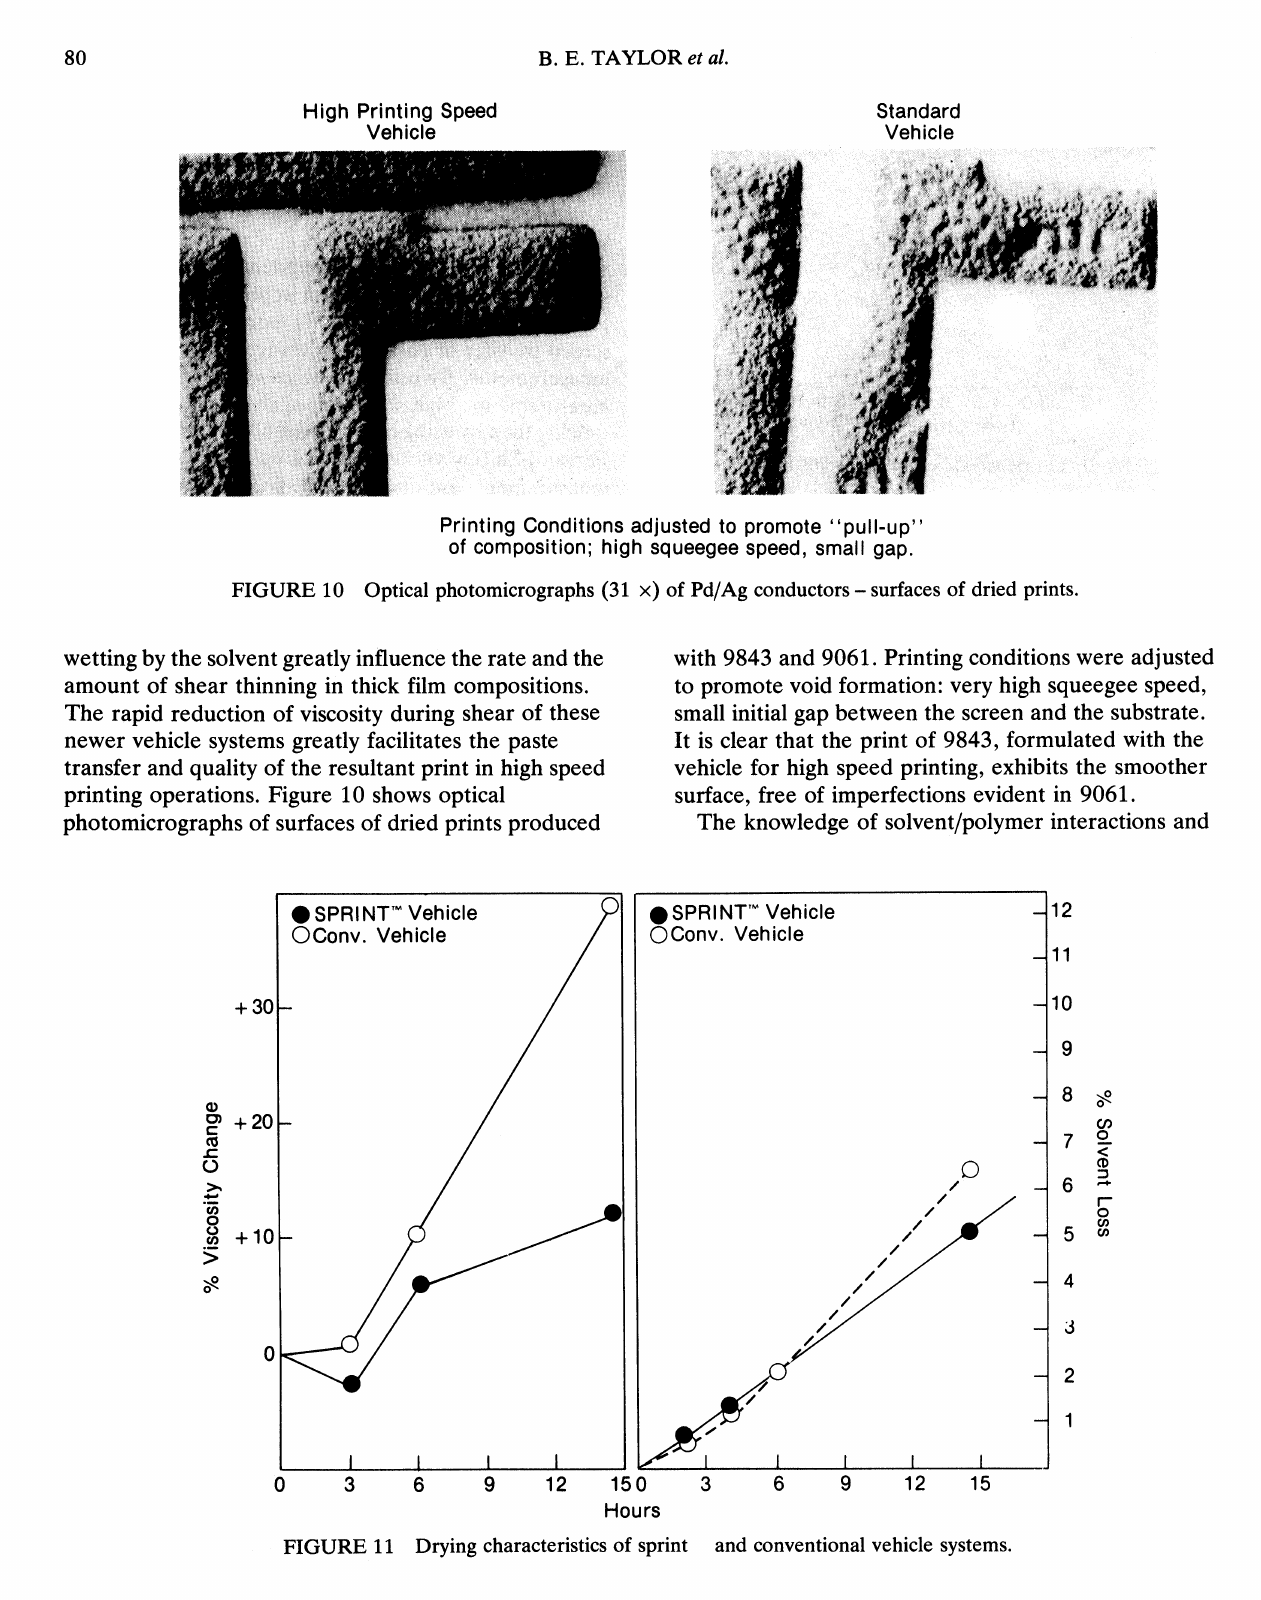
FIGURE 11 Drying characteristics of sprint and conventional vehicle